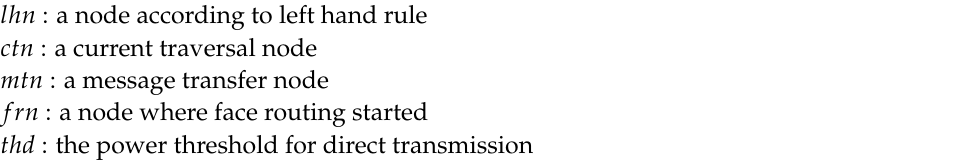
Algorithm 2 Selecting the most remote node using the GG edge list and sending a